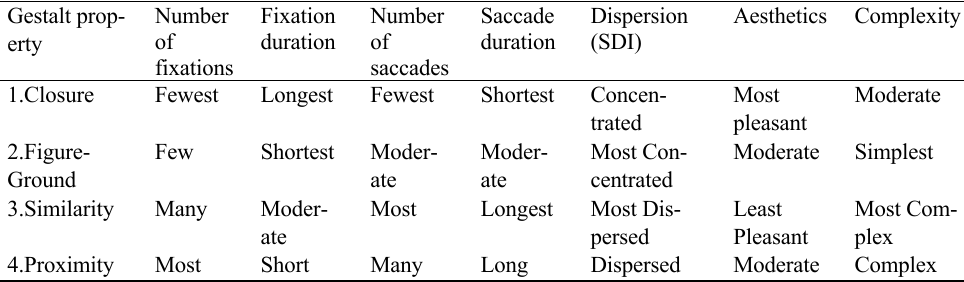
Comprehensive Analysis of Gestalt Photography and Eye Movement Characteristics Gestalt prop-